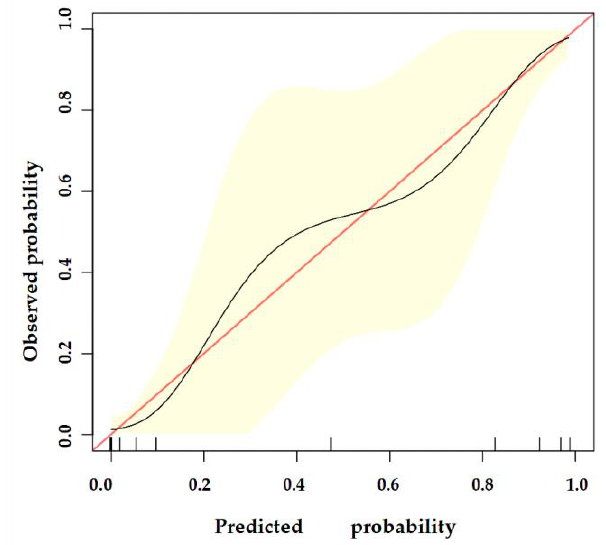
Figure 8. The calibration curve of our model. The y-axis represents the actual probability of breast malignancy, and the x-axis represents the observed probability. The red line represents the perfect prediction of an ideal model. The black line represents the predictive performance of our model, and the yellow shaded area represents our model’s 95% CI. Our model demonstrates good consistency between predicted and actual probabilities.